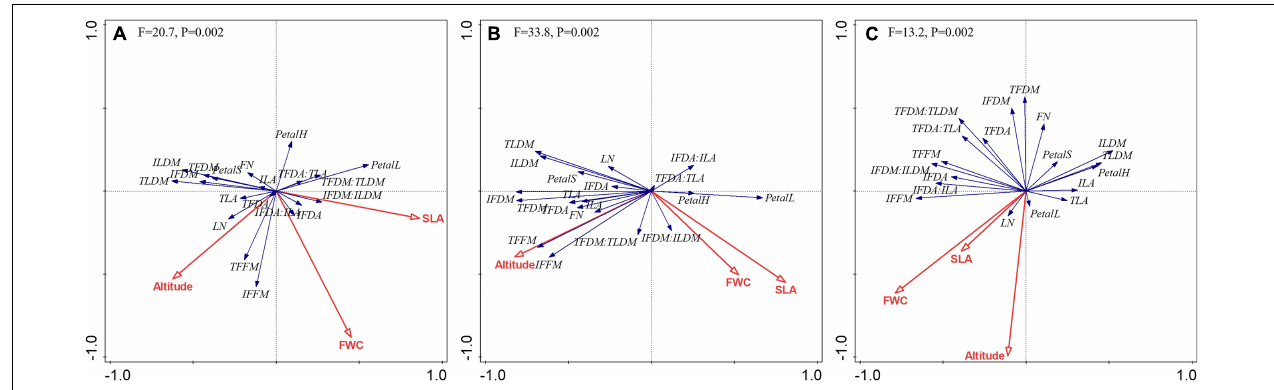
FIGURE 5 | Redundancy analysis of the relationship among floral color, floral traits, leaf traits, and environmental factors under different altitude ranges: (A) 2,950–3,650 m, (B) 2,950–3,300 m, and (C) 3,300–3,650 m.